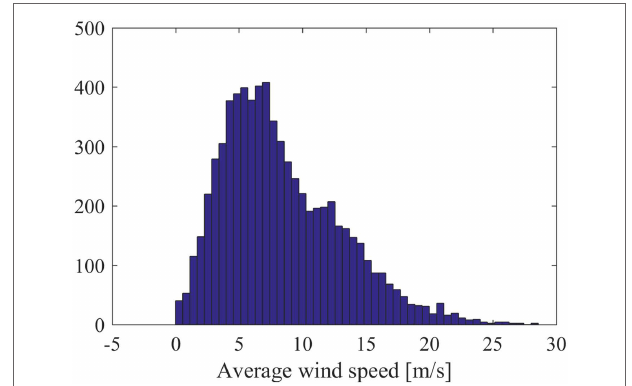
FIGURE 1 | Histogram displaying the distribution of the average wind speeds available for the identification of the